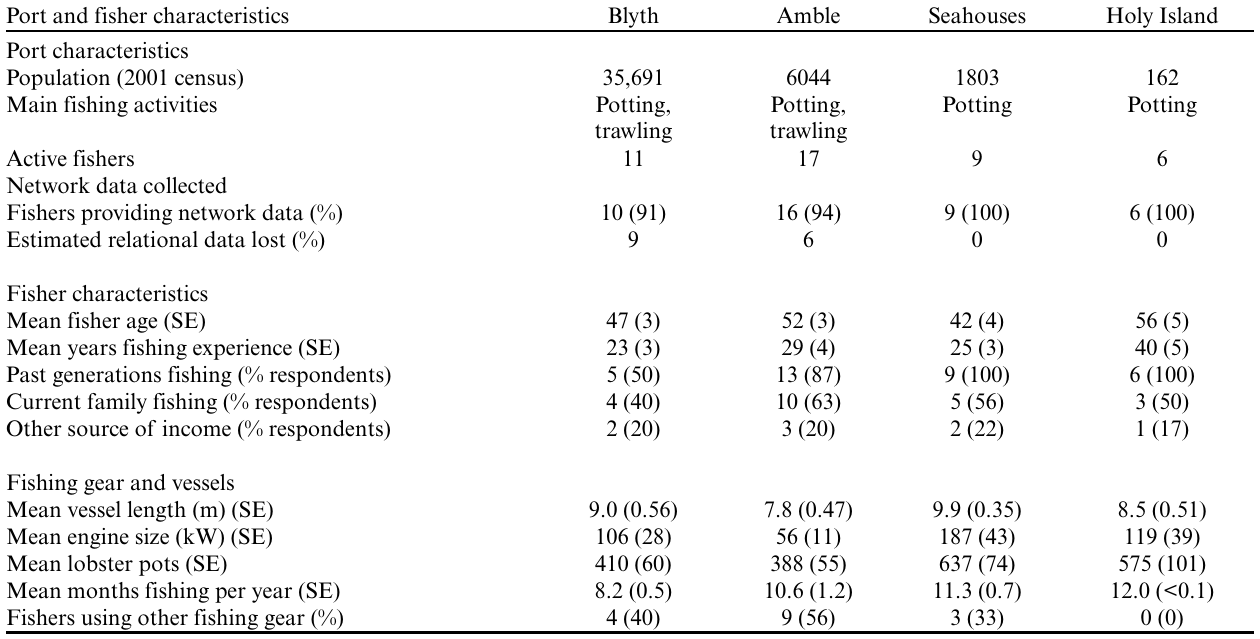
Table 1 . Summary of data collected and characteristics of fishers interviewed at each port. Estimated relational data lost was calculated as 100 - k , where k is the sample size as a percentage of the population (Burt 1983). Data on fishers, gear, and vessels reflect characteristics of the interview